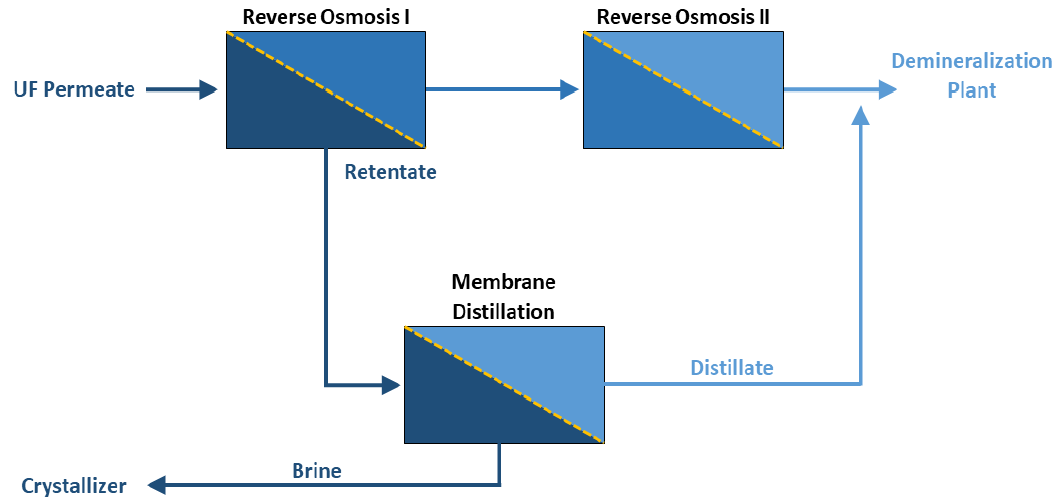
Figure A3. Membrane surface after the NaCl experiment.